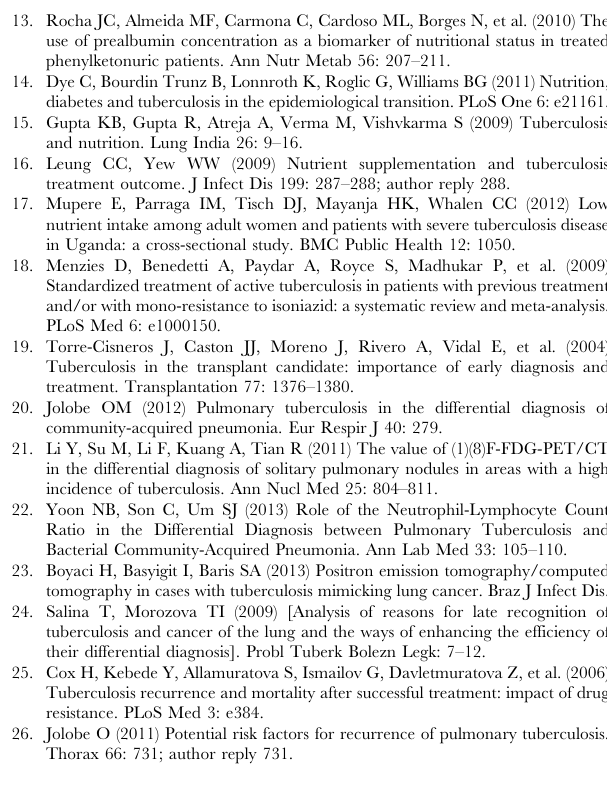
Figure 2. The change of serum PA levels in different group of patients. Serum PA levels slowly elevated after the TB patients accepted anti-TB drugs. Nine months after use of anti-TB drugs, the average of serum PA levels (194.1 6 29.2 mg/L) among these TB patients significantly rised to normal range. However, the serum PA levels of drug-resistant TB patients remained at a low level state. The serum PA levels in lung cancer patients were slowly reduced after chemotherapy.